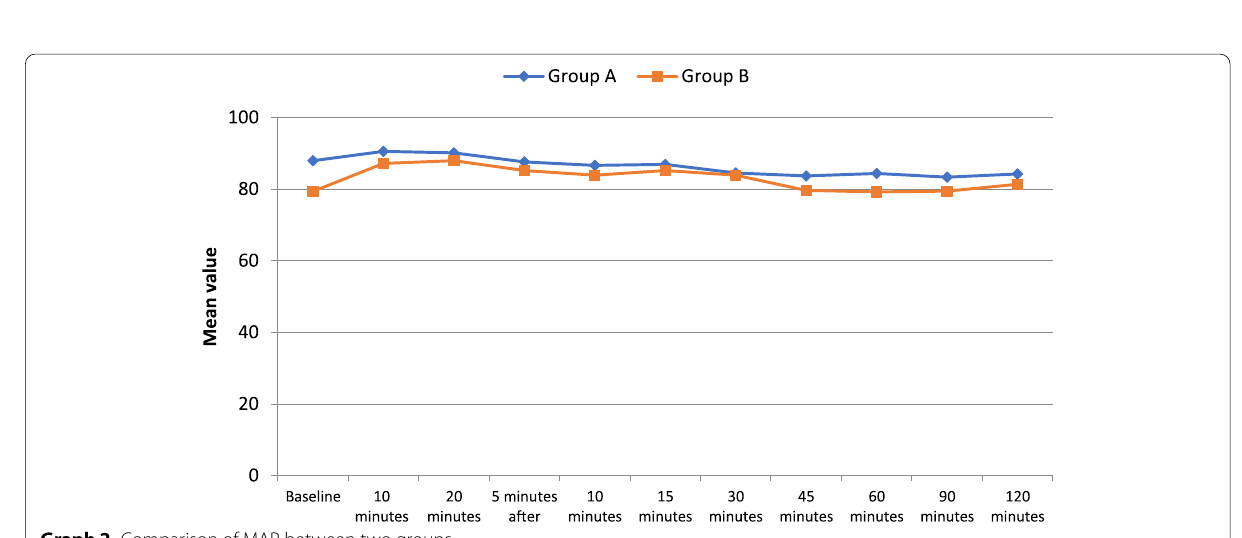
Graph 2 Comparison of MAP between two